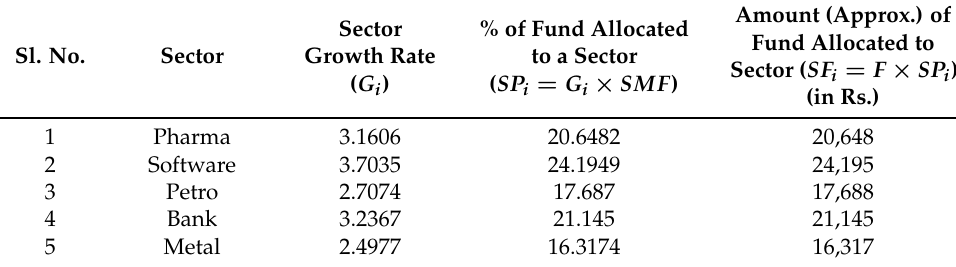
Table 3. Sector-wise fund